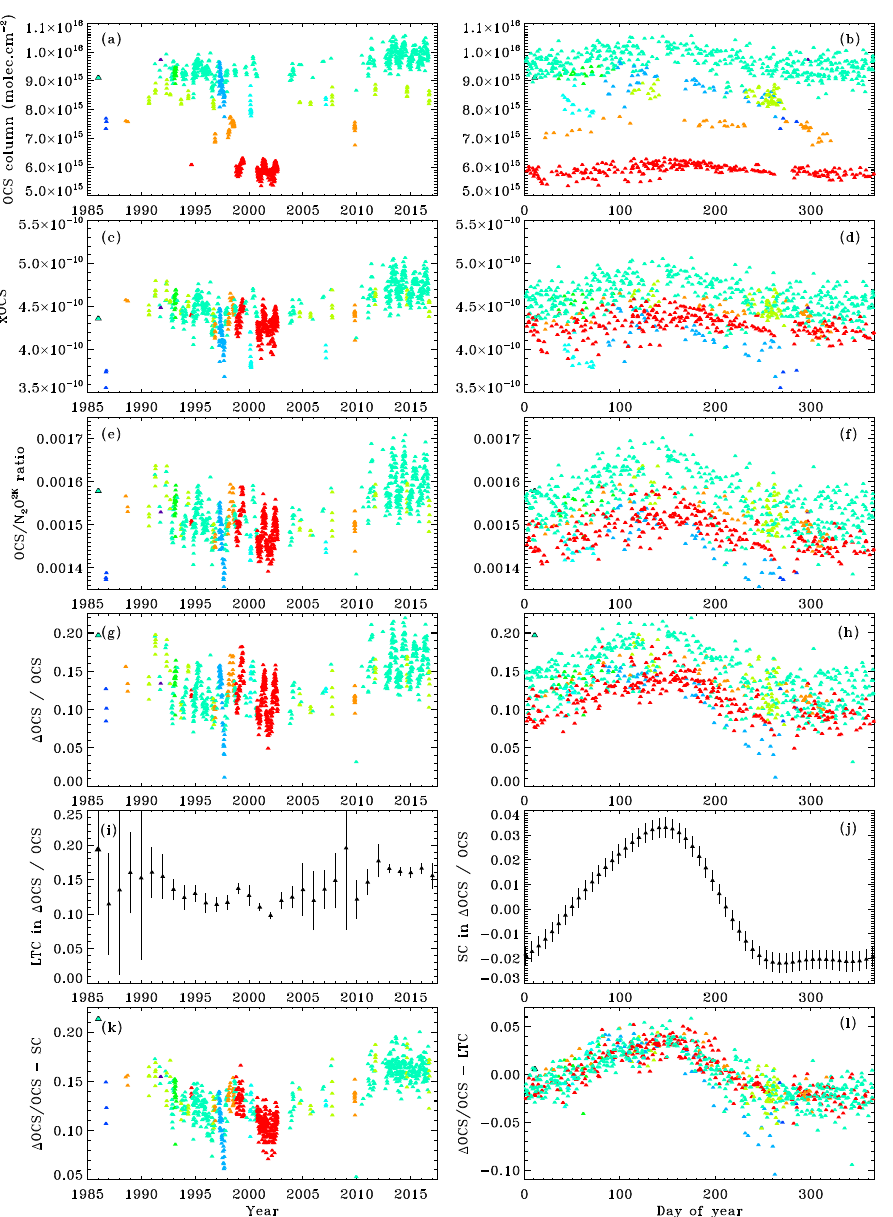
Figure 6. Ground-based measurements of OCS, color-coded by site altitude (e.g., dark blue: 0km; light blue: 0.1km; green: 0.3km; lime: 1.2km; orange: 2.1km; red: 3.8km). The left-hand panels show the OCS plotted versus year, revealing the long-term changes (LTC). The right-hand panels show the same data plotted versus the day of the year, revealing the seasonal cycle (SC). Panels (a, b) show the raw column abundances, which are much larger at the lower-altitude sites. Panels (c, d) show the column-averaged OCS amounts (xOCS), which reduces the altitude and site dependence. Panels (e, f) show the OCS / N 2 O column ratios, which further reduce the altitude–site dependence. Panels (g, h) show (cid:49) OCS, the difference between the measured OCS, and the N 2 O-based prediction described in Appendix A. Subtracting the N 2 O-derived OCS amount eliminates dynamically induced variations common to both gases, revealing the tropospheric behavior with more fidelity. Panels (i, j) show the LTC and the SC extracted from the (cid:49) OCS results by simultaneously fitting a linear spline and harmonic terms. Panel (k) shows the (cid:49) OCS data with the SC subtracted. Panel (l) shows the SC with the LTC subtracted. For right-hand panels without y -axis labels (b, d, f, h) , the left-hand panel labels are